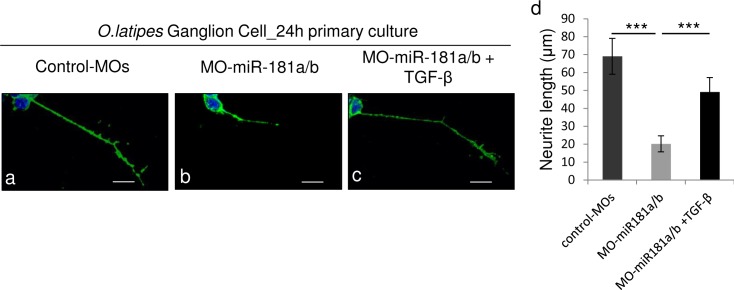
TGF-β administration rescues axon defects in miR-181a/b depleted RGCs.
(a-c) Representative images from primary RGC cultures from St30 control-MOs (a), miR-181a/b morphant (b) and TGF-β-treated miR-181a/b morphant medaka fish embryos (c). The RGC axon length defect was rescued by treatment with TGF-β (c). Scale bars: 10μm. (d) Quantification of RGC axonal length. Data are means +SEM (n = 100) from three independent cell culture experiments. ***P <<0.001 (one-way ANOVA).